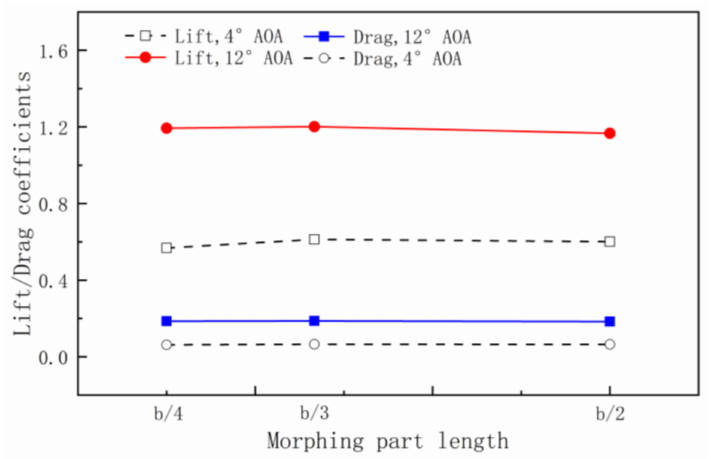
Figure 9. Comparisons of lift/drag coefficients with different morphing part lengths.